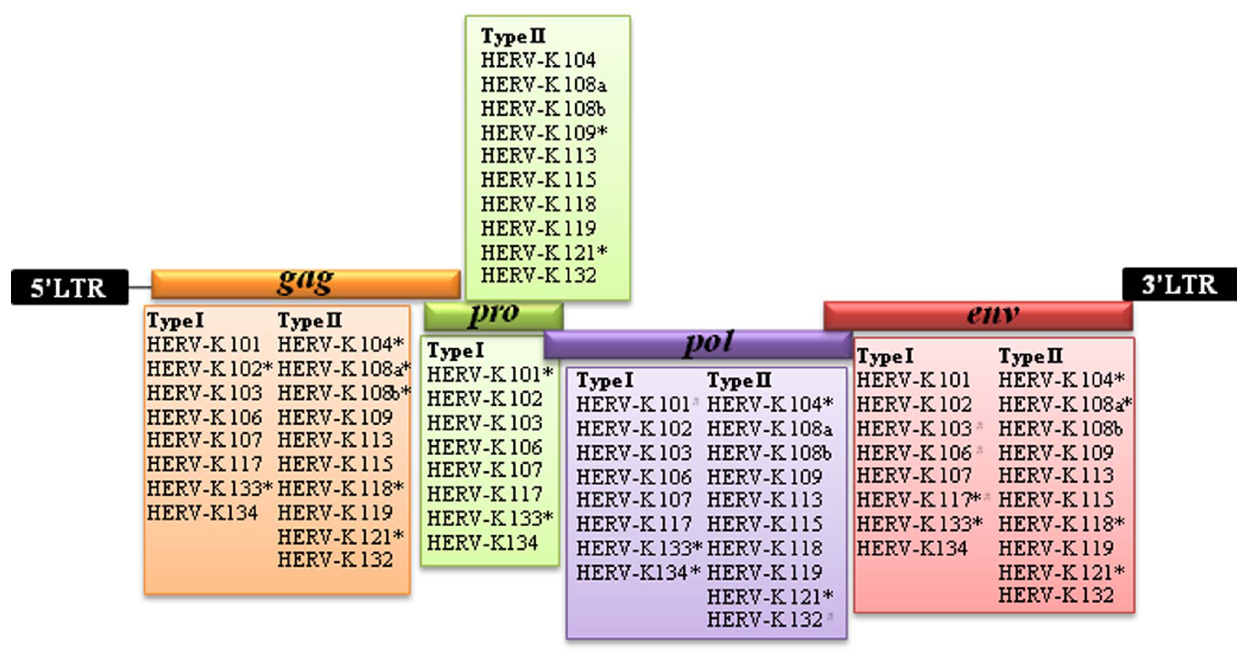
Figure 4. Diagram of a human-specific full-length HERV-K element. The ORFs of gag , pro , pol , and env are depicted as colored boxes. HERV-K members that contain versions of gag , pro , pol , and env are listed under each HERV genes (* and # indicate that the HERV-K locus contains stop codon or broken frame, respectively).